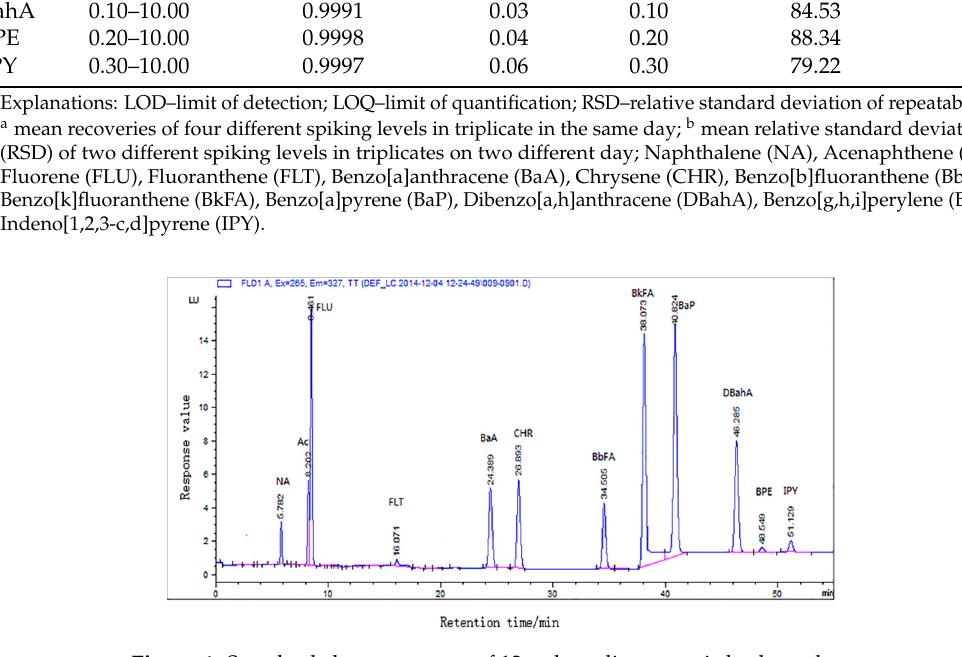
Figure 1. Standard chromatogram of 12 polycyclic aromatic hydrocarbons. Table 1. Parameters of validation of 12 polycyclic aromatic hydrocarbons (PAHs) in sausages.